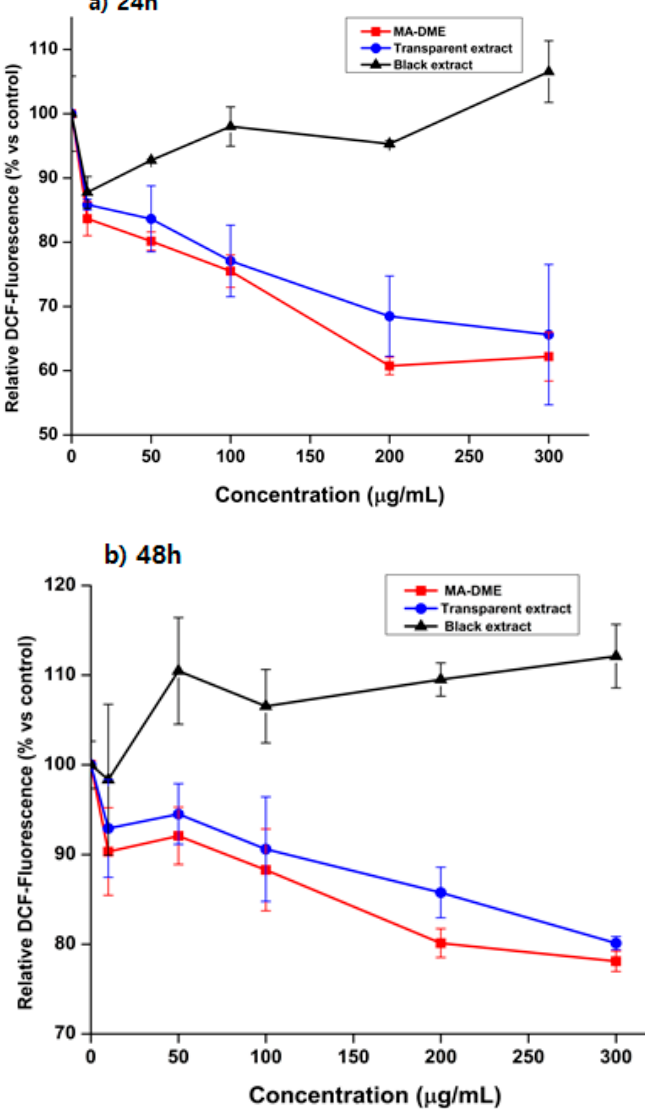
Figure 4. The effect of MA-DME on ROS compared with Black extract and Transparent extract for ( a ) 24 h, ( b ) 48 h , n = 3.